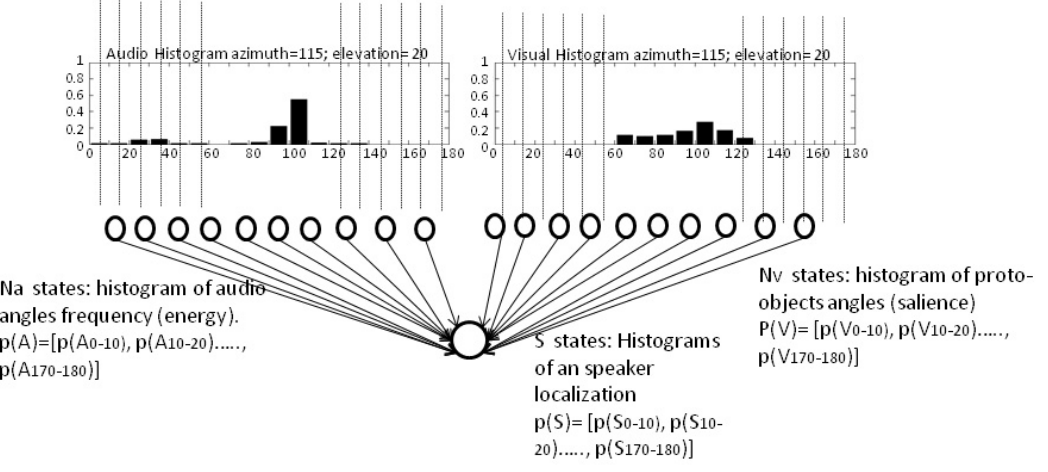
The Bayesian network used to infer the speaker localization based on the histograms of the audio and visual